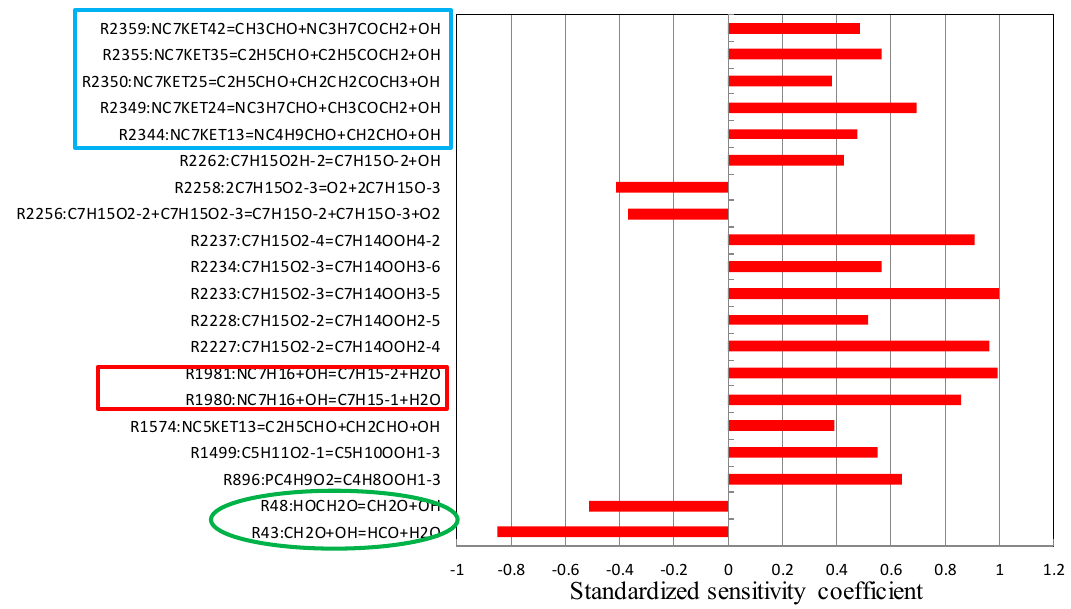
Figure 10. OH sensitivity analysis of N-heptane in the condition of 550 K.